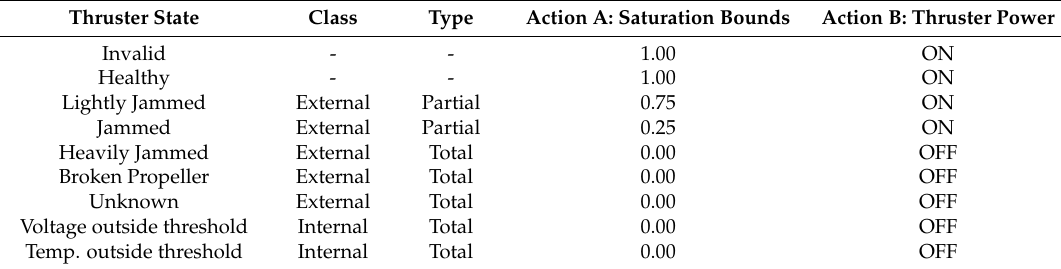
Table 3. Thruster Fault Code